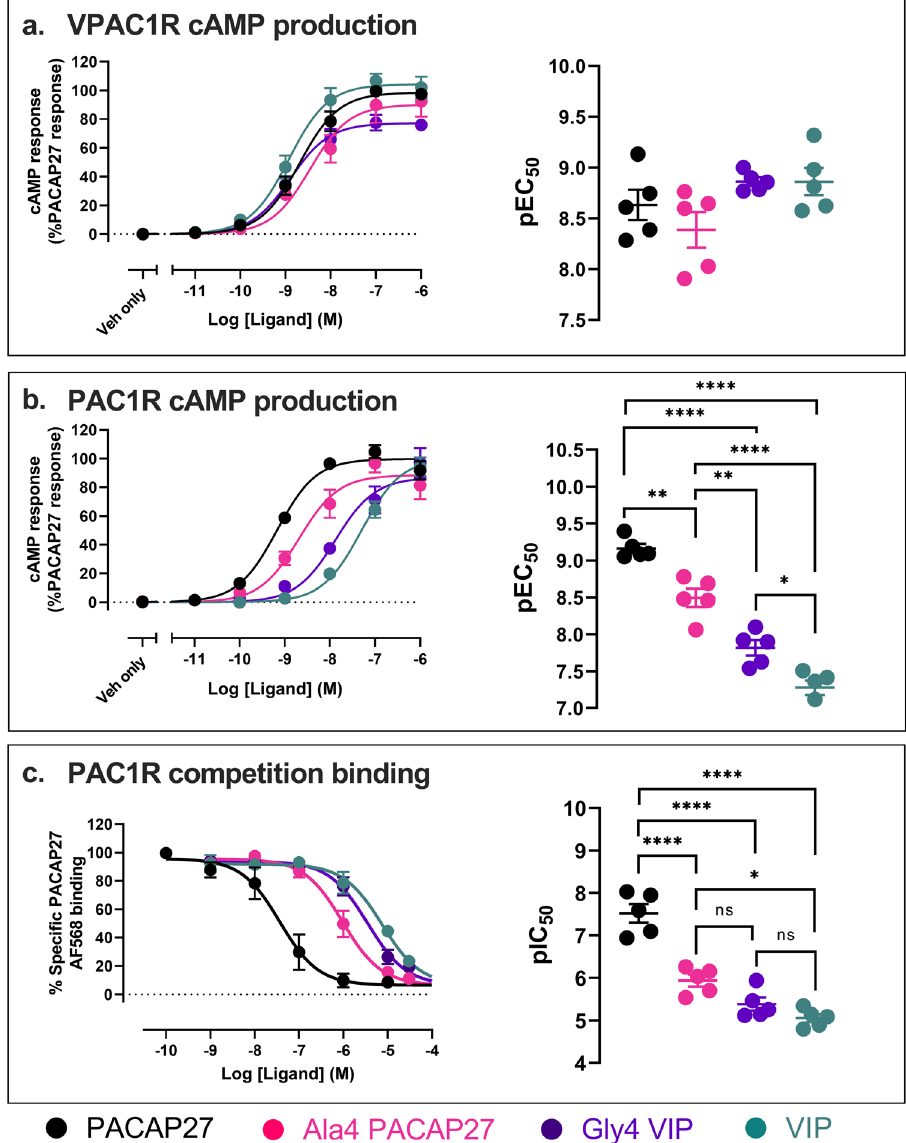
Fig. 5 | cAMP production and competition binding assays using PACAP27, VIP and chimeric peptides Ala4-PACAP27 and Gly4-VIP. Pharmacological char- acterization of PACAP27 (black), VIP (turquoise) and the chimeric peptides Ala4- PACAP27 (pink) and Gly4-VIP (purple); ( a ) VPAC1R cAMP production, ( b ) PAC1R cAMP production and (c) PAC1R competition binding. a , b Left, Concentration – response curves for cAMP production normalized to % PACAP27 response (data are the mean±SEM from 5 independentexperiments);right, pEC 50 determined from each individual experiment are shown with mean±SEM of the 5